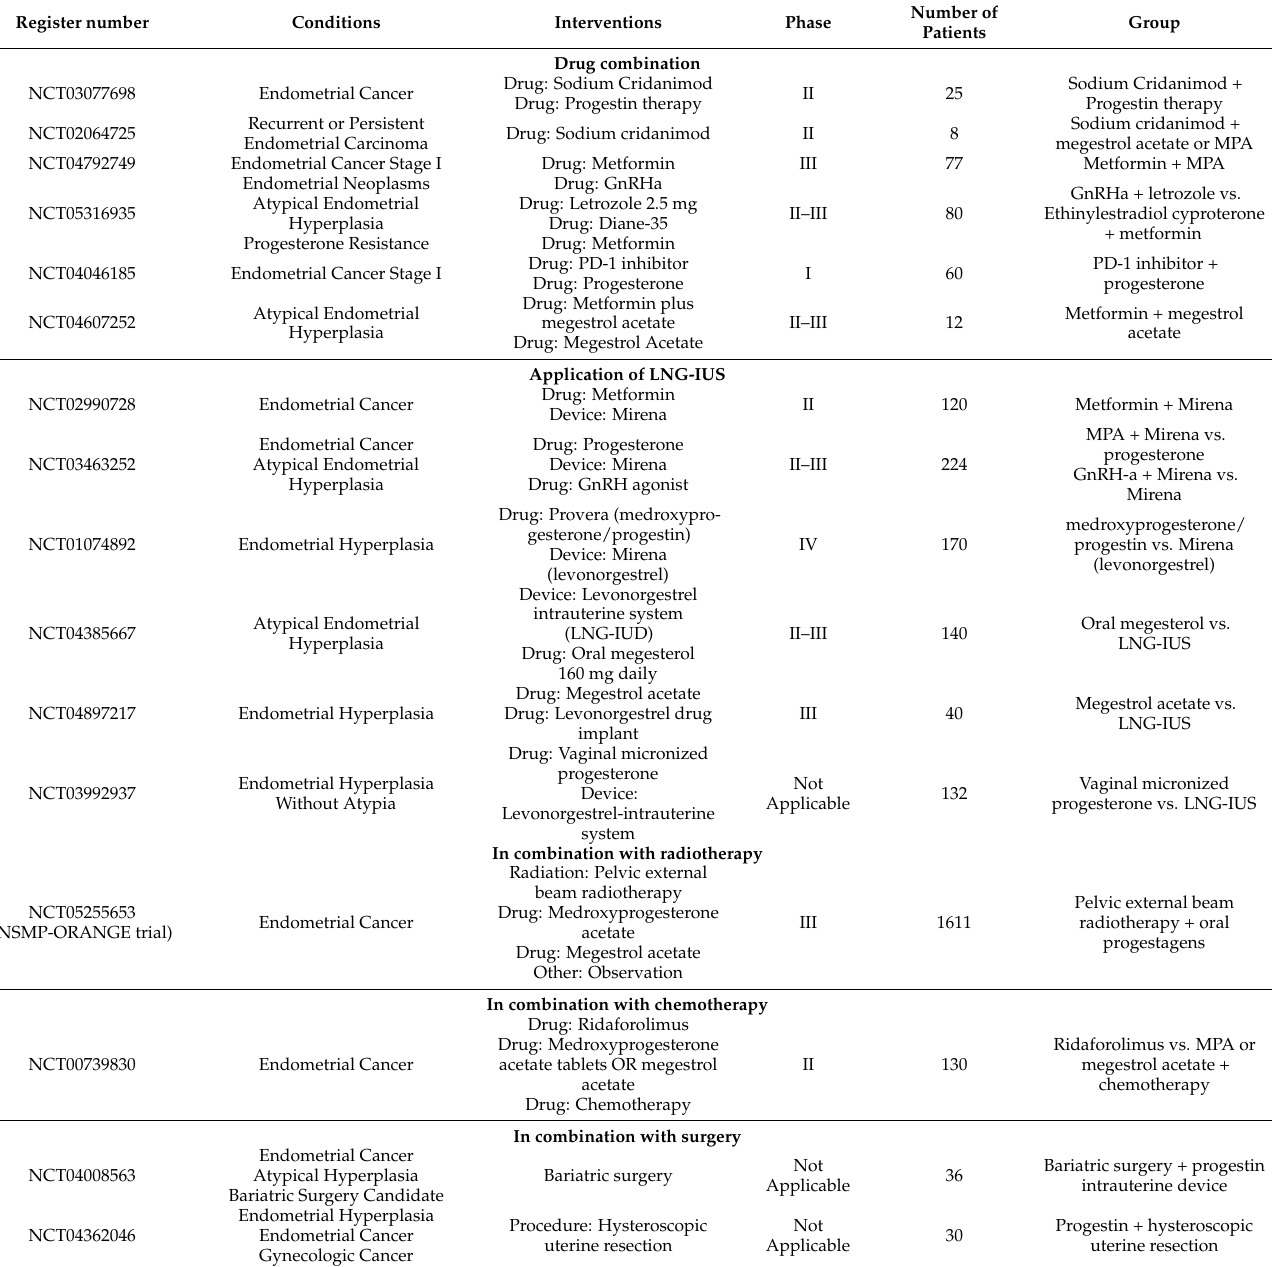
Table 2. Overview of current clinical trials investigating novel progestin therapeutic strategies in EH and EC